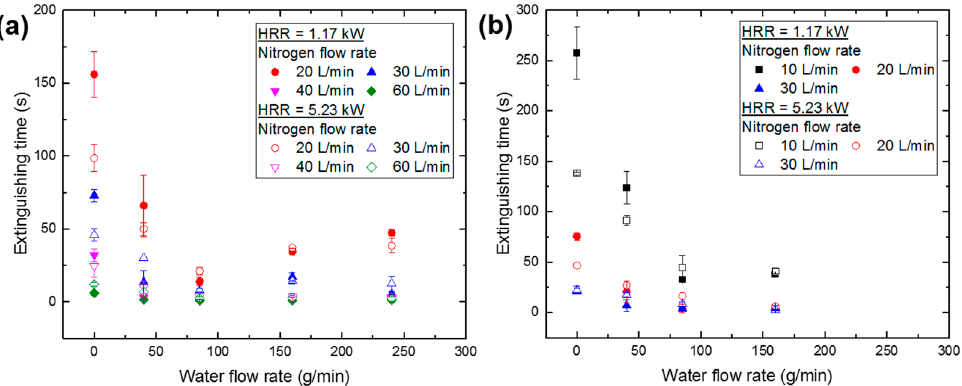
Figure 4. Extinguishing time for large and small atomizers under different HRR conditions (note that the scales of y -axis in both figures are different): ( a ) large atomizer and ( b ) small atomizer.